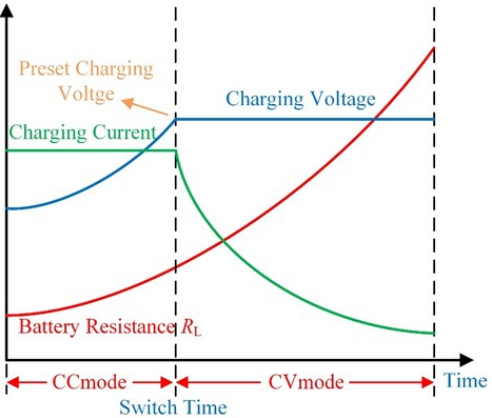
Figure 1. Lithium-ion battery charging curve.